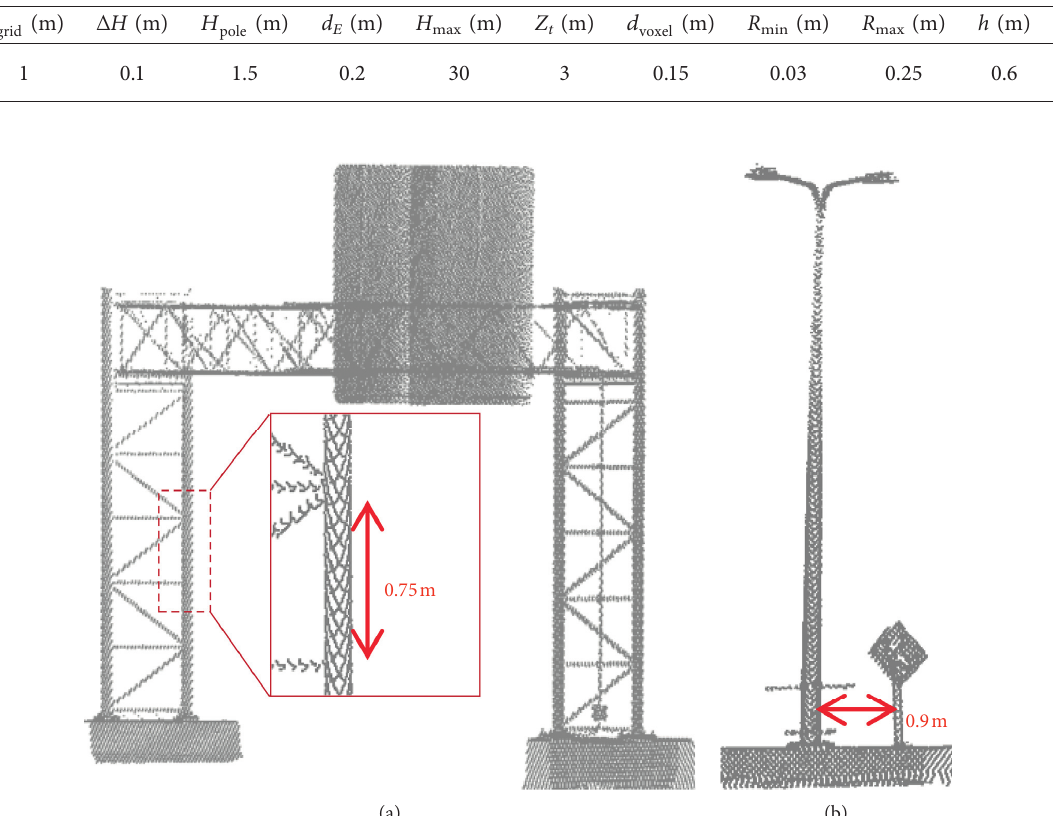
and minimum vertical height h . (b) Selection of voxel